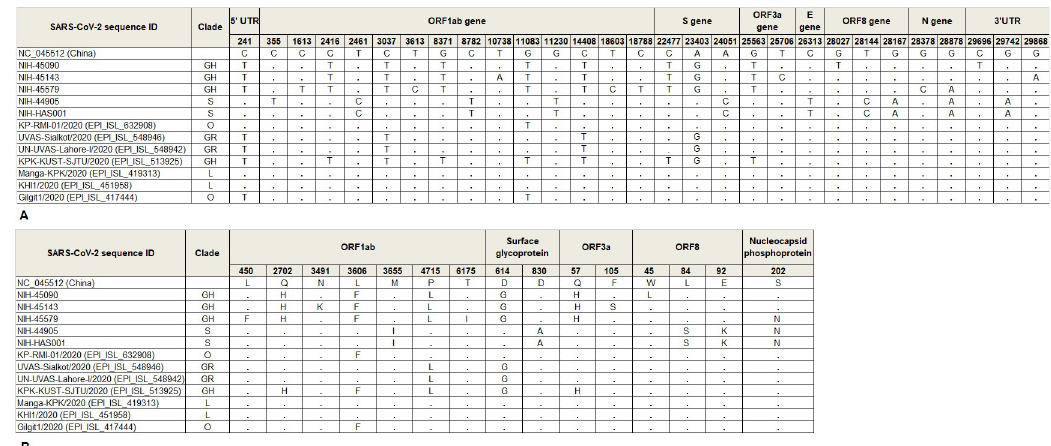
Fig 3. Comparison of SARS-CoV-2 isolates sequenced in the current study with the prototype strain and Pakistan isolates. The nucleotide changes are shown in A and the amino acid variations are presented in B.